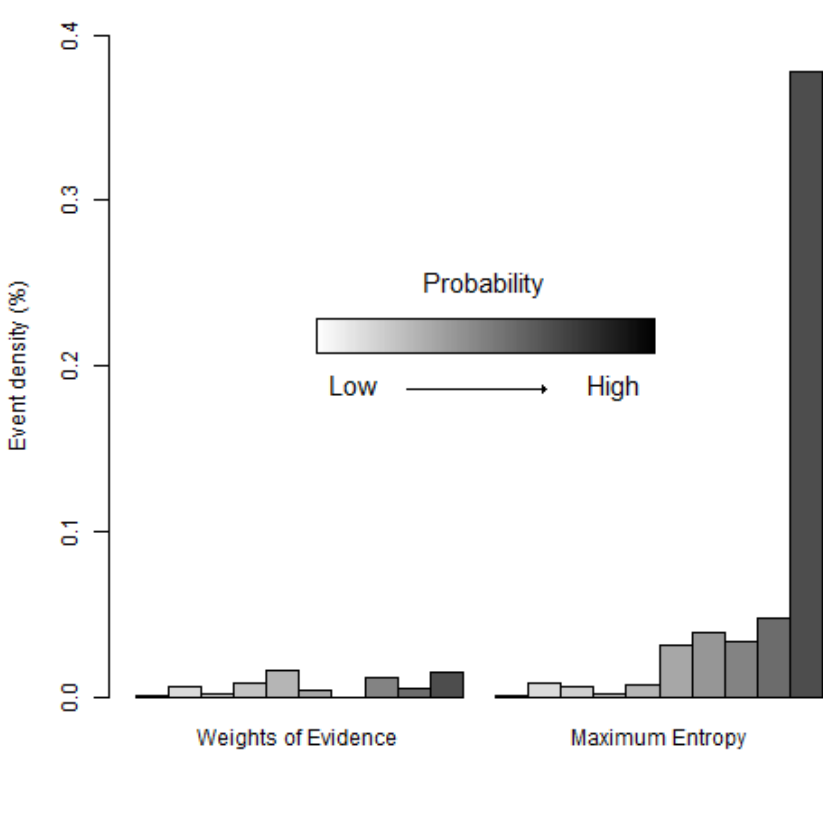
Figure 11. Density of species occurrence expressed as a proportion (%) in each bin (Equation (5)). Bins are ordered with lower probabilities on the left and higher probabilities on the right using the equal probability increment